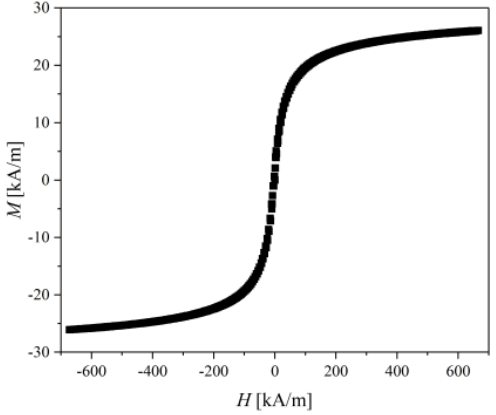
Figure 6. Magnetization curve of lab-made magnetic fluid.